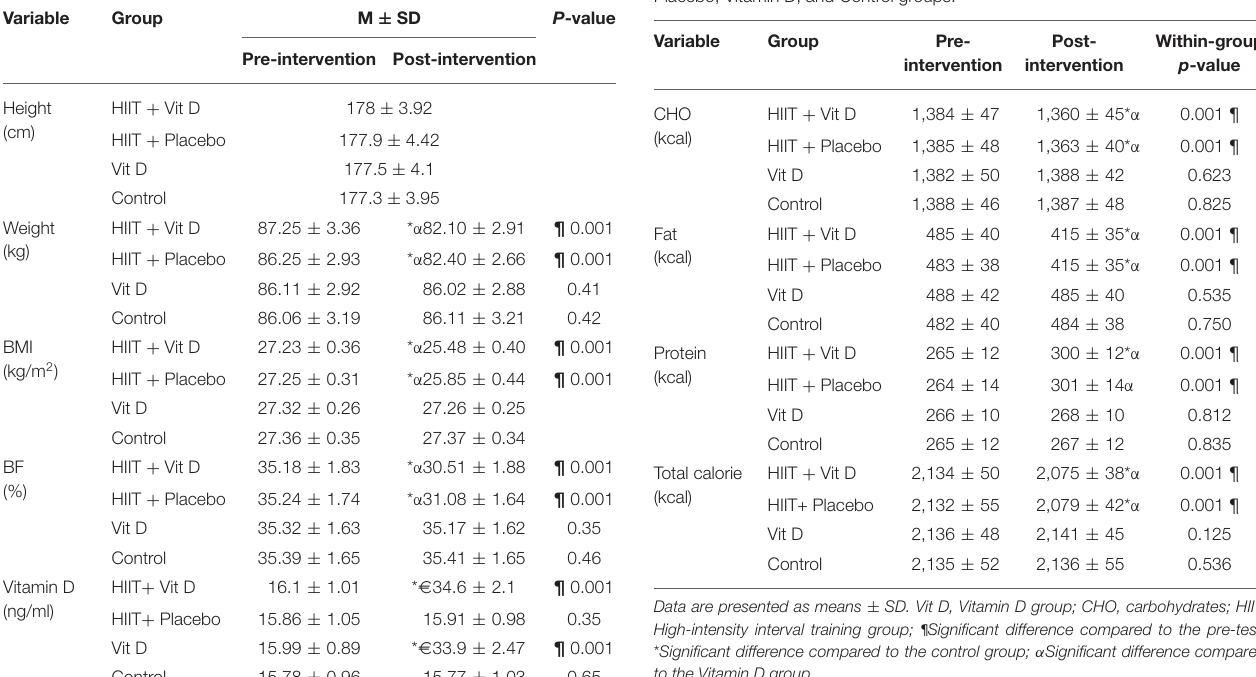
TABLE 2 | The mean calorie intake of the subjects in the HIIT + Vitamin D, HIIT + Placebo, Vitamin D, and Control